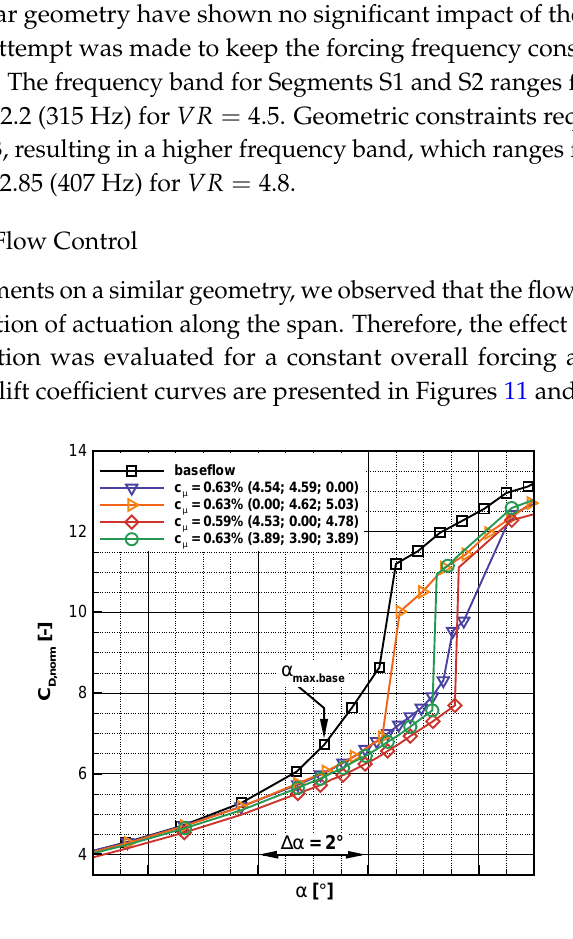
Figure 11. Drag coefficient for forcing with c µ ≈